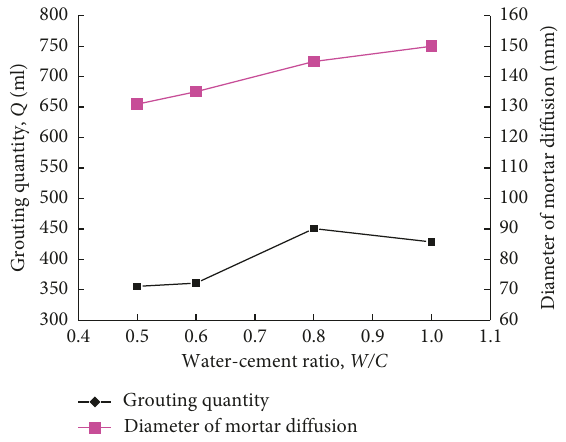
Figure 21: Characteristics of slurry diffusion ( P � 0.3MPa, k 3 � 0.93cm/s).